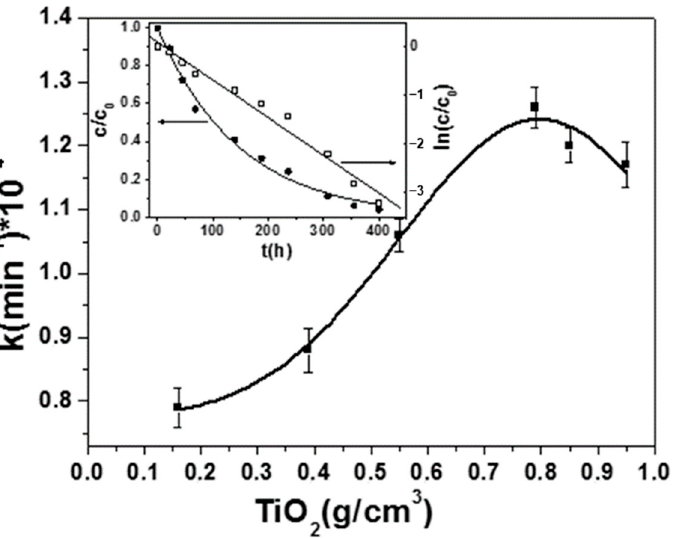
Figure 2. Influence of the TiO 2 dosage on the degradation rate (Methyl Orange (MO) = 0.7 mg/L; Q = 0.066 L/s, h w = 13.5 cm, tests no. 1–6). In the inset: c/c 0 vs. t and ln(c/c 0 ) vs. t correlations relative to test no. 4 (MO = 0.7 mg/L; TiO 2 = 0.79 g/cm 3 ; Q = 0.066 L/s, h w = 13.5 cm).